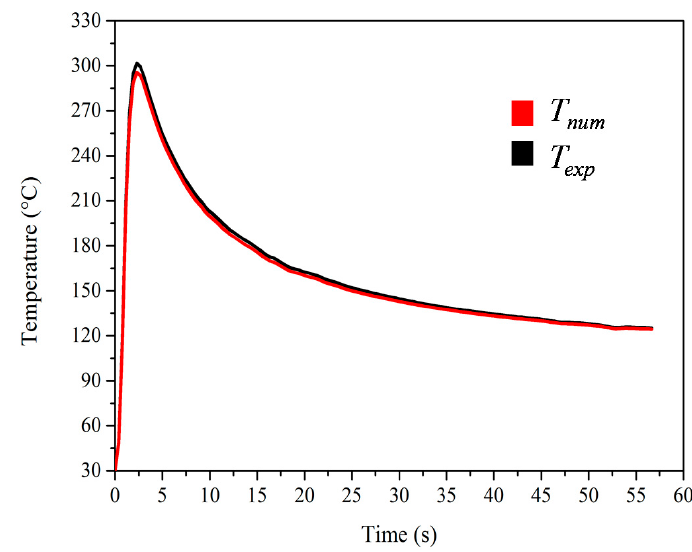
Figure 12. Numerical temperature ( T num ) and experimental temperature ( T exp ) for GTA welding in stainless steel AISI 304L.